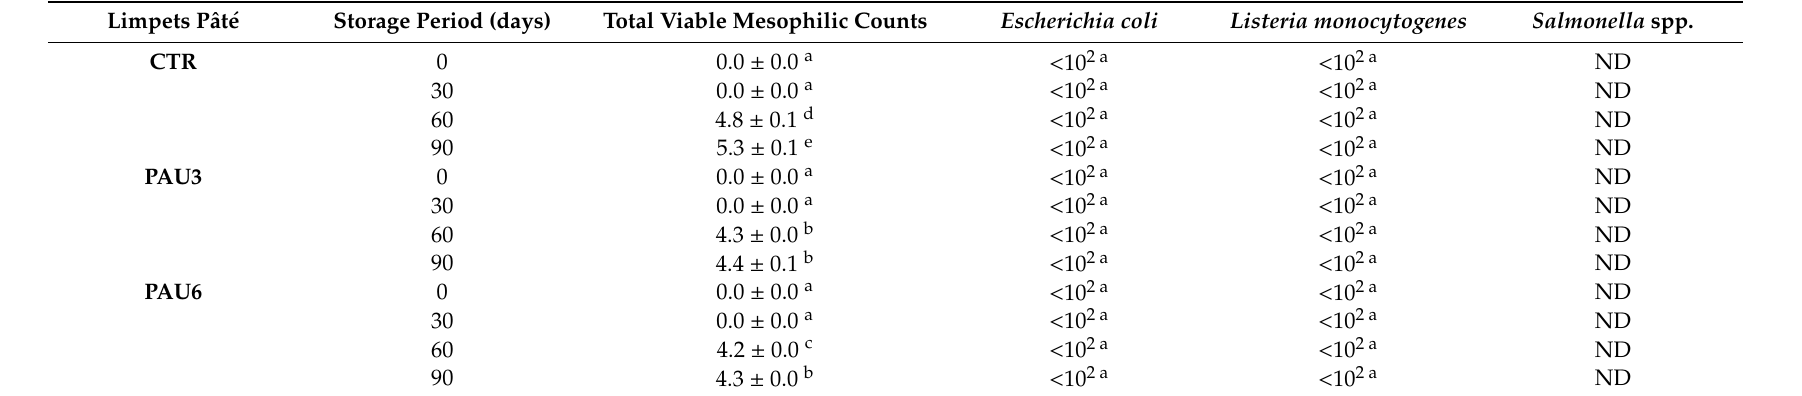
ND—not detected. In each column and between lines, di ff erent letters represent significant di ff erences ( p -value <